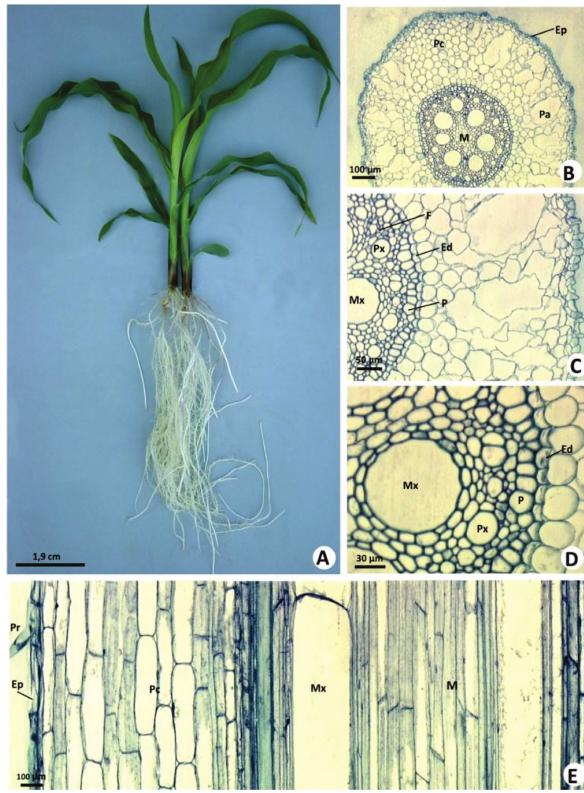
Figure 2. a) Corn plant grown in nutrient solution